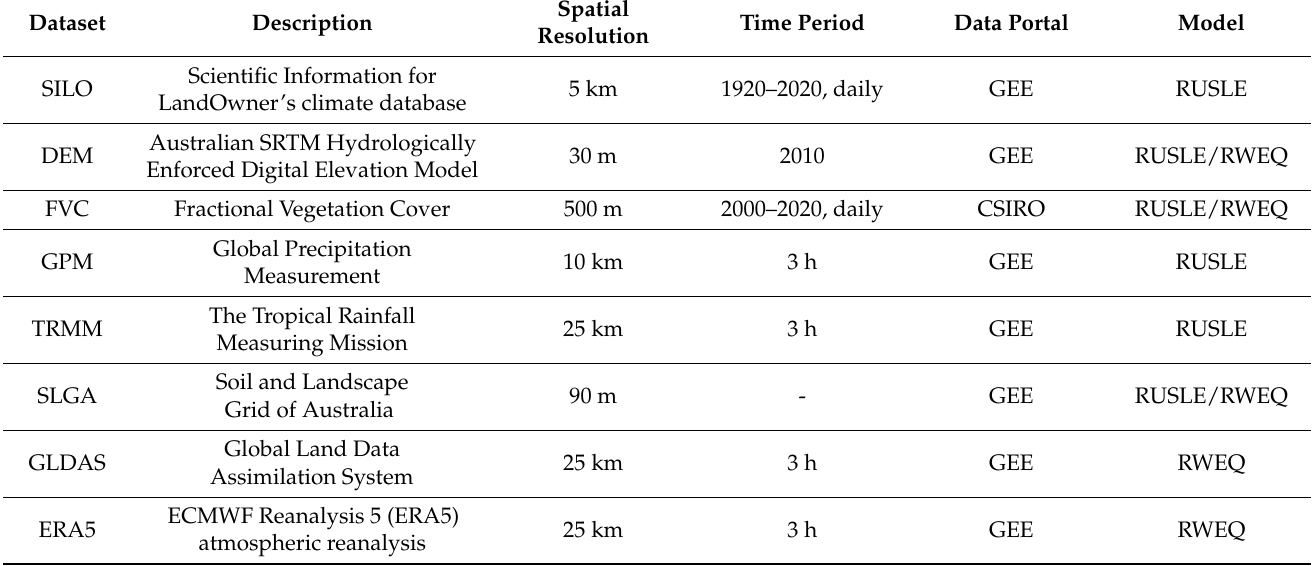
Table 1. Datasets used in this